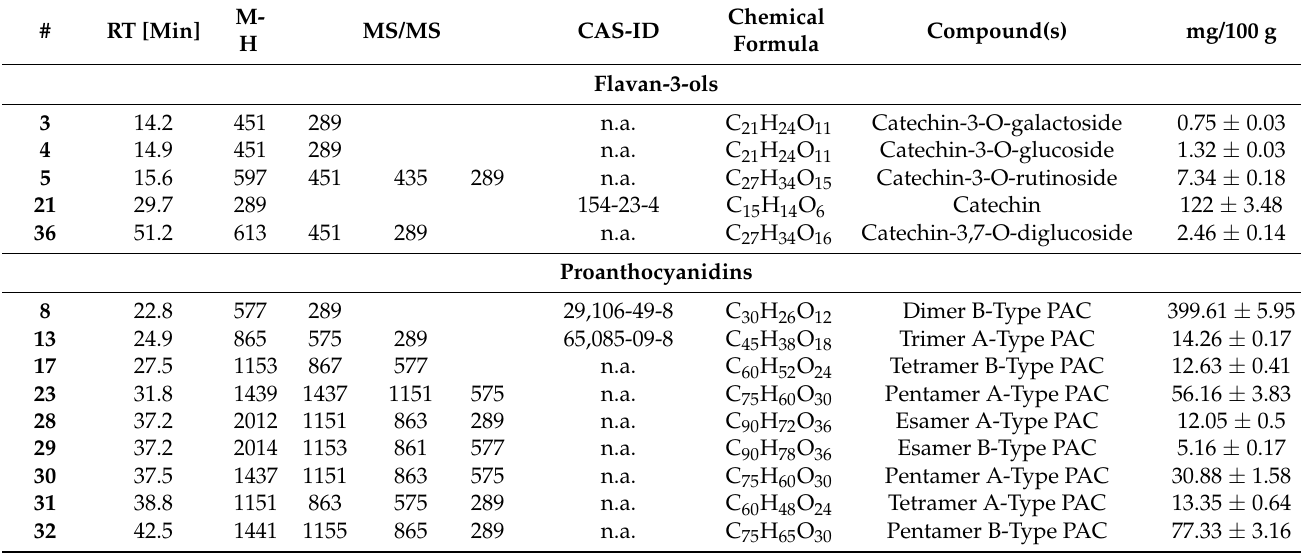
Table 2. Qualitative and quantitative phytochemical characterization of flavan-3-ols and proantho- cyanidins in WRSP extract. Results (mg per 100 g of FW) are expressed as mean ± SD of three different